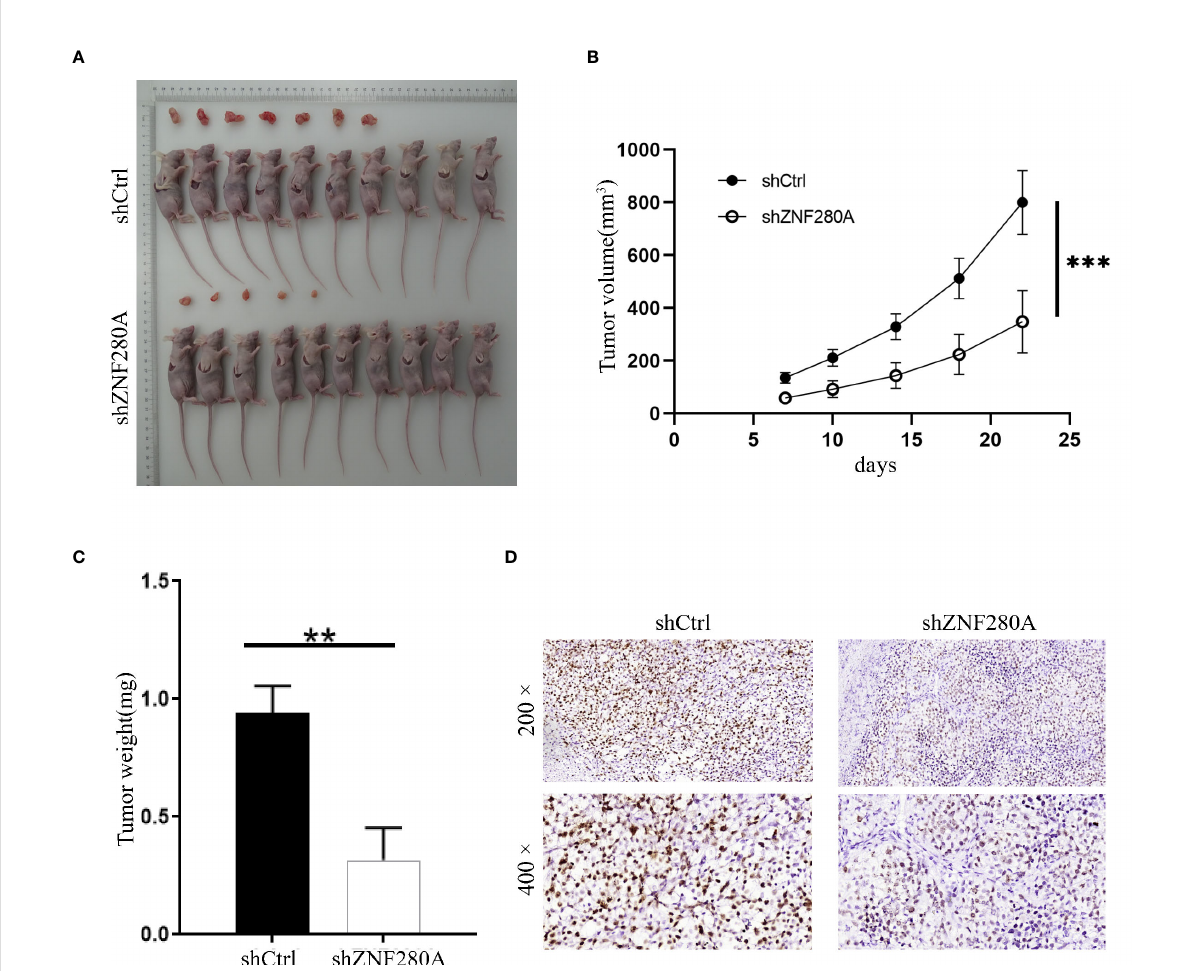
FIGURE 3 ZNF280A knockdown inhibits the tumor tumorigenesis of CRC in vivo. (A) Photos of tumors removed from the BALB/c mice at day 35 after the injection of RKO cells with or without ZNF280A knockdown. (B) Tumor volumes of mice in shZNF280A and shCtrl groups were measured. (C) The excised tumors from the mice were weighed. (D) The expression levels of Ki67 in the sections sliced from the excised tumors were detected by IHC staining. Scale bar: 50 m m. Data were shown as mean 1 ± 2 SD. **P < 0.01, ***P <